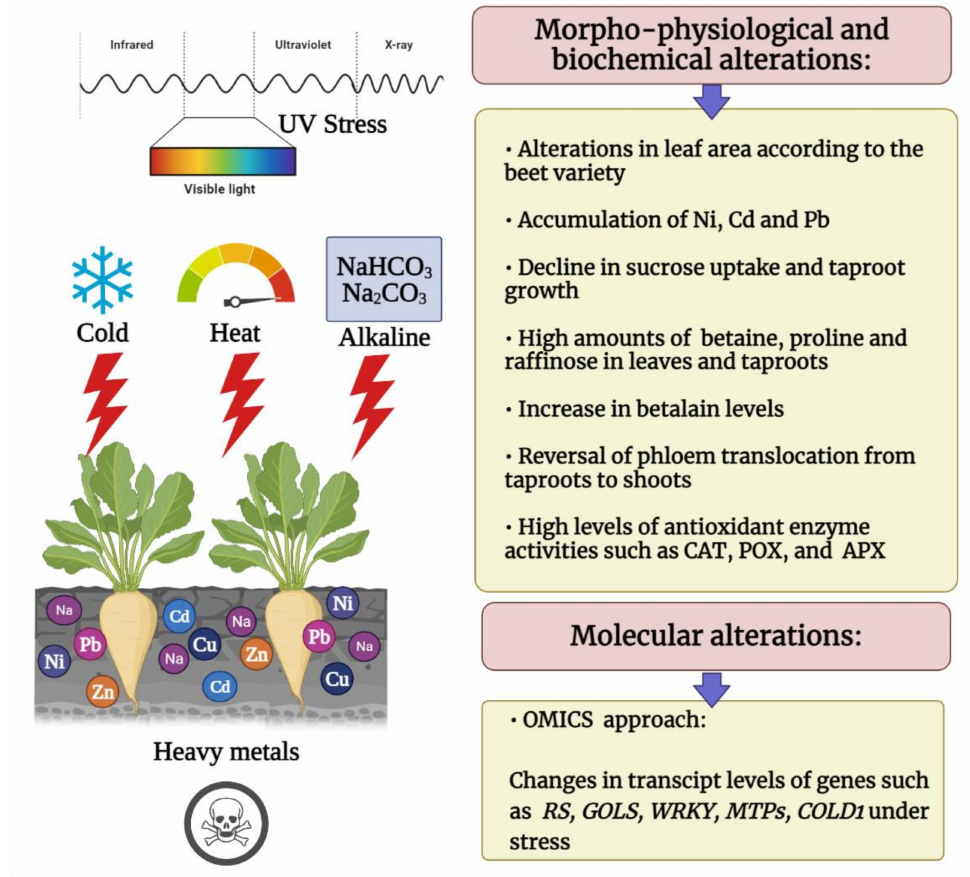
Figure 1. Schematic representation of morpho-physiological, biochemical, and molecular alterations in beets under alkaline, cold, heat, heavy metal, and UV conditions. This figure was created via BioRender.com (accessed on 12 December